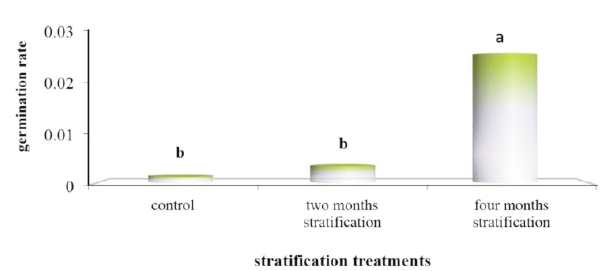
fig. 3 - effect of stratification treatments on seed germination rate of hazelnut cultivars.